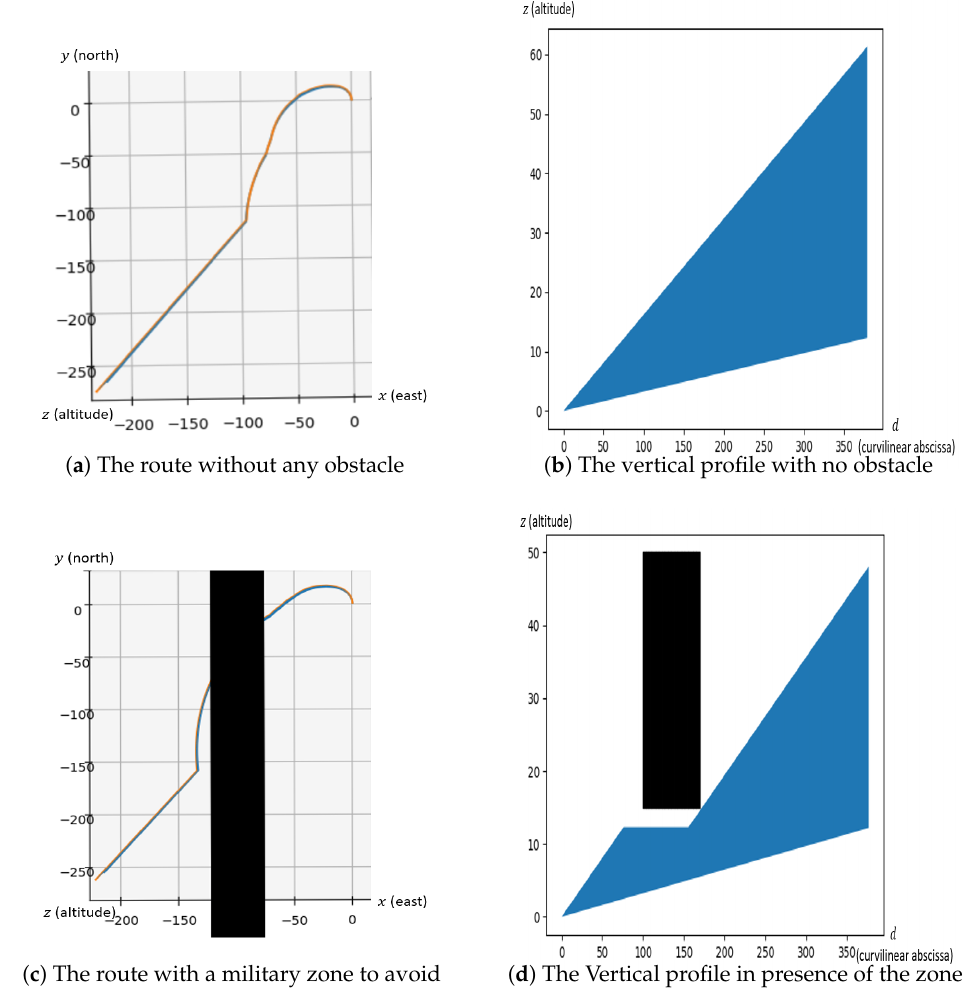
Figure 13. The effects of a military zone on the route